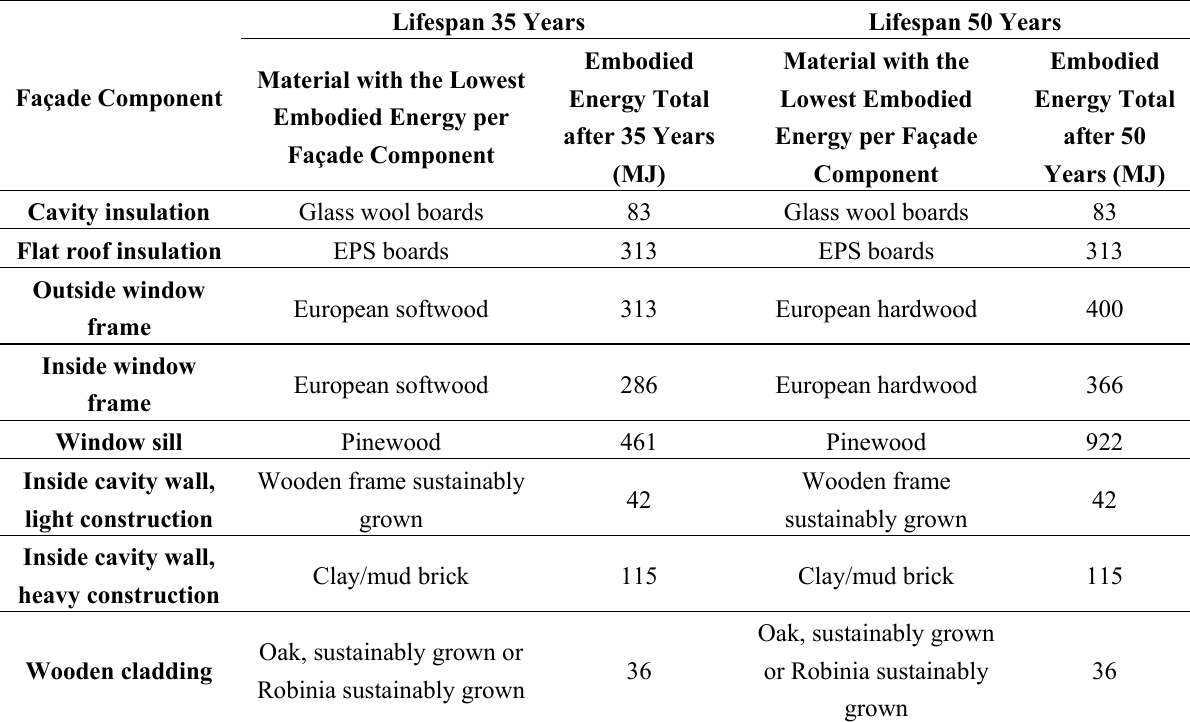
Table 2. Materials with the lowest embodied energy for 35- and 50-year lifespan per component type, for 1 m 2 of